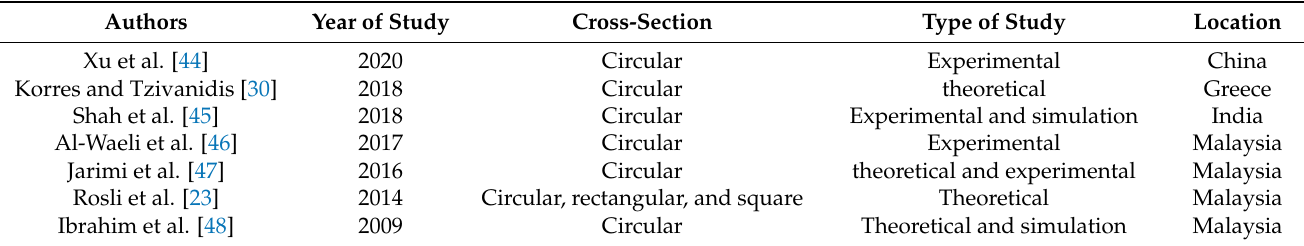
Table 1. Literature reviews regarding serpentine designs with different